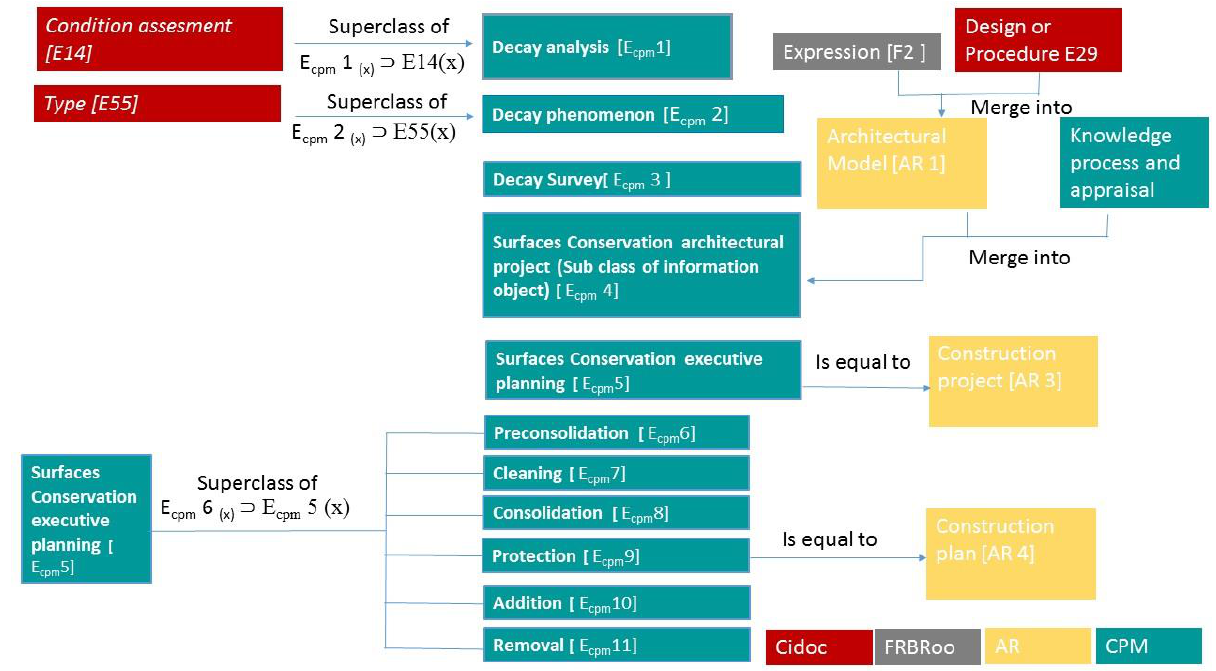
Figure 4. Classes formalization and integration within existing